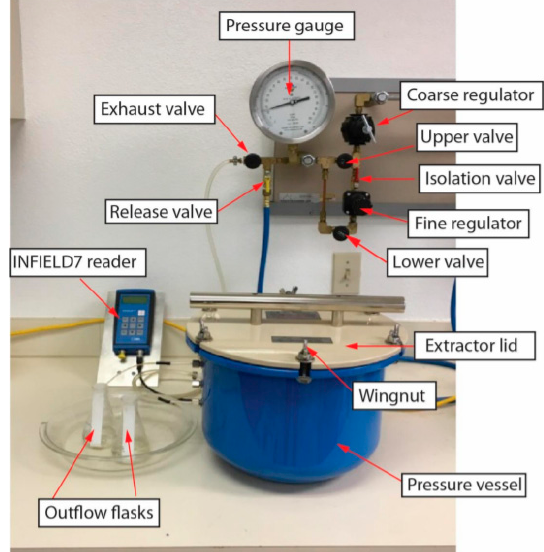
Figure 5. Pressure vessel using a regulated air system [32] .